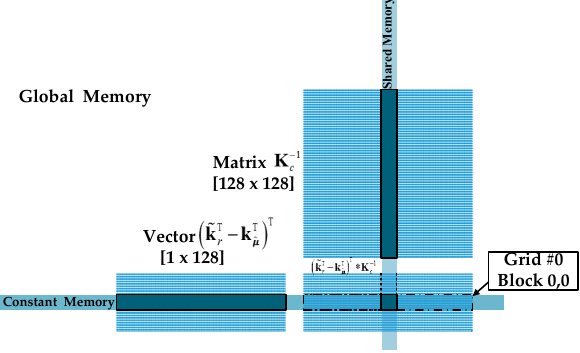
Figure 6. Illustration of thread for computing one element of result in GPU.